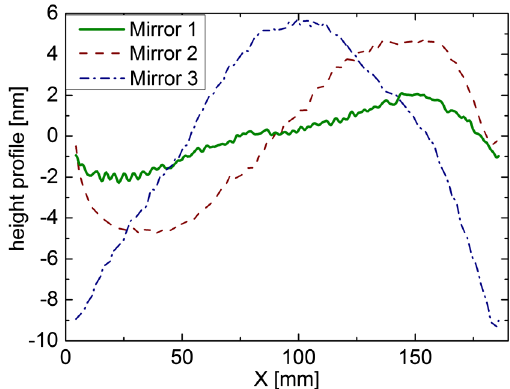
FIG. 2. The height profile of three mirrors: mirror 1 (green line) Δ h ¼ 4 nm PV; mirror 2 (red, dashed line) Δ h ¼ 9 . 5 nm PV; mirror 3 (blue, dash-dotted line) Δ h ¼ 15 nm